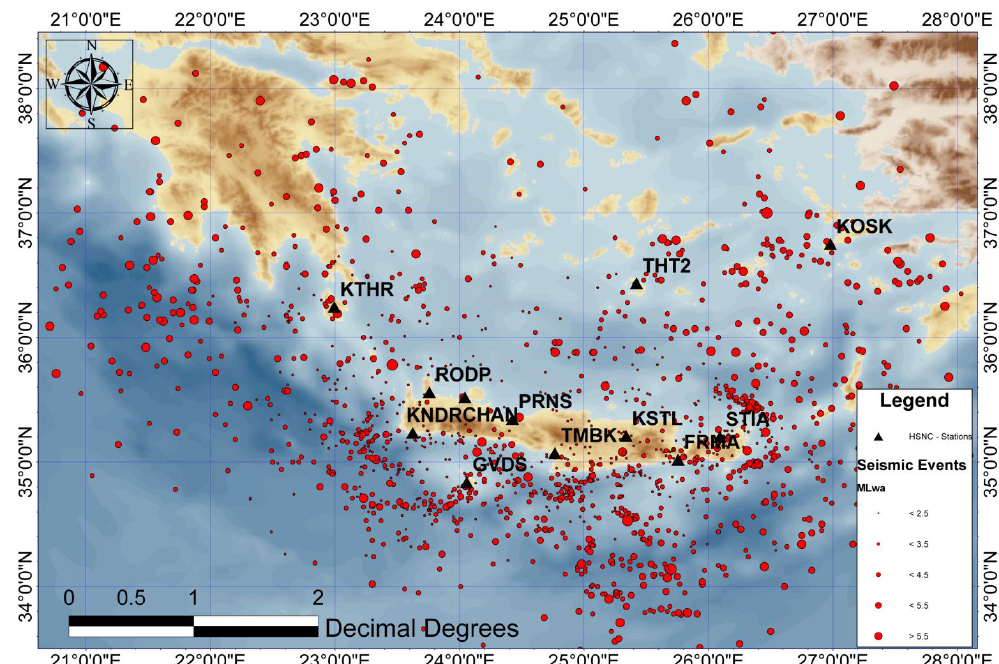
Fig. 2. HSNC stations and the seismic events recorded from 2008 until 2012.